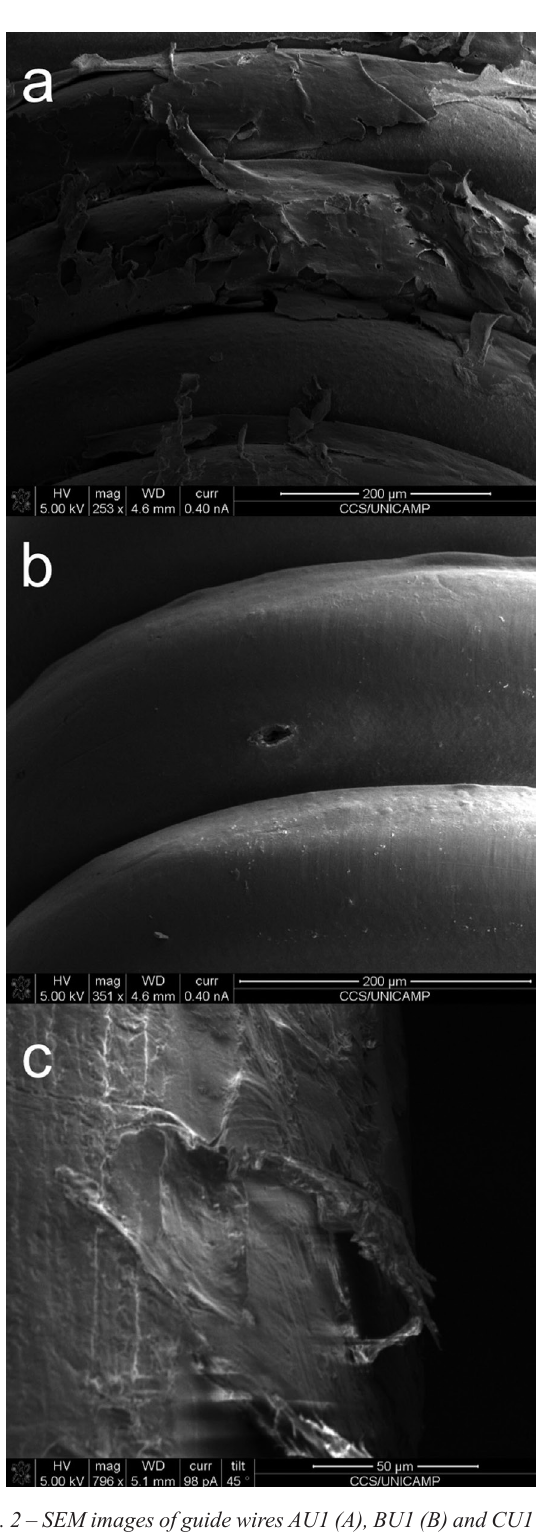
2 – SEM images of guide wires AU1 (A), BU1 (B) and CU1 (C), washing 1X using enzymatic detergent in ultrasonic bath. Debris and holes of considerable size are observed mainly in Figures A and C, while bubbles and a non-conformal surface are observed in Figure